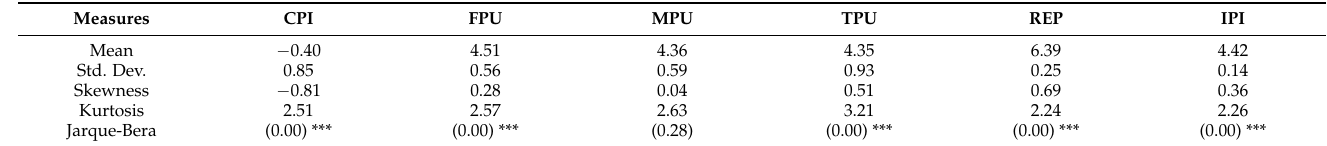
Table 1. Descriptive